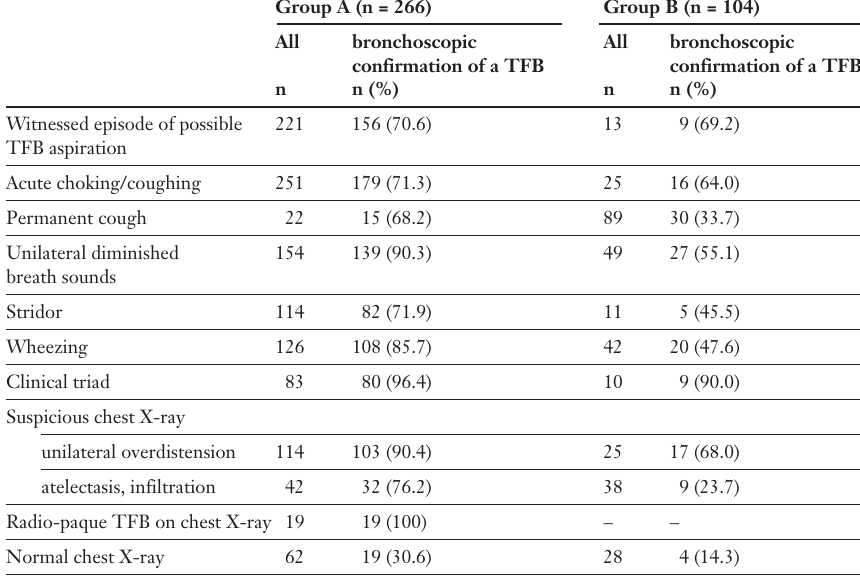
Table 2 Clinical and radi- ographic findings in patients with sus- pected TFB aspiration summarised for group A and